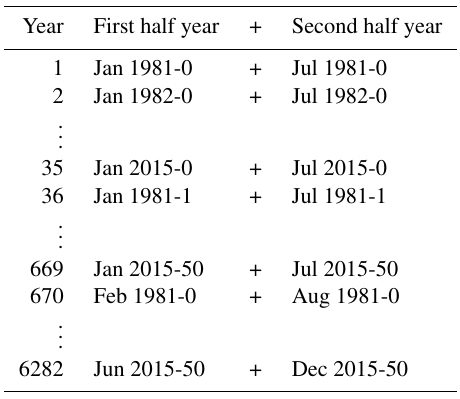
Table 1. Combination of individual forecast members to construct the 6282-year time series. The numbers indicate the start year (1981–2015) followed by the perturbation number (0–50). See the text for further